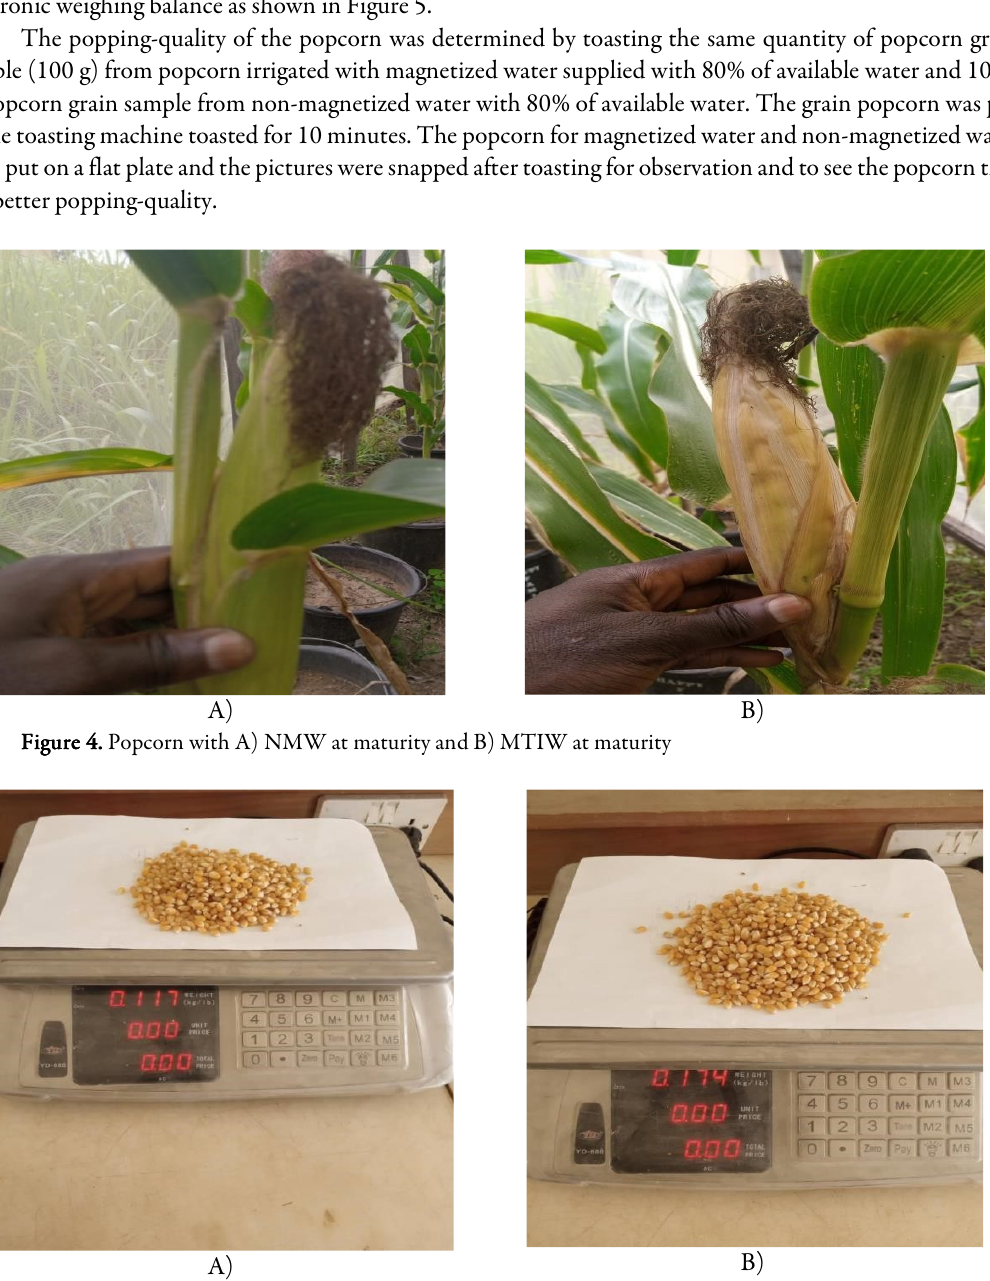
Figure 5. Figure 5.Figure 5. Figure 5. Determination of yield of popcorn A) NMW and B) with